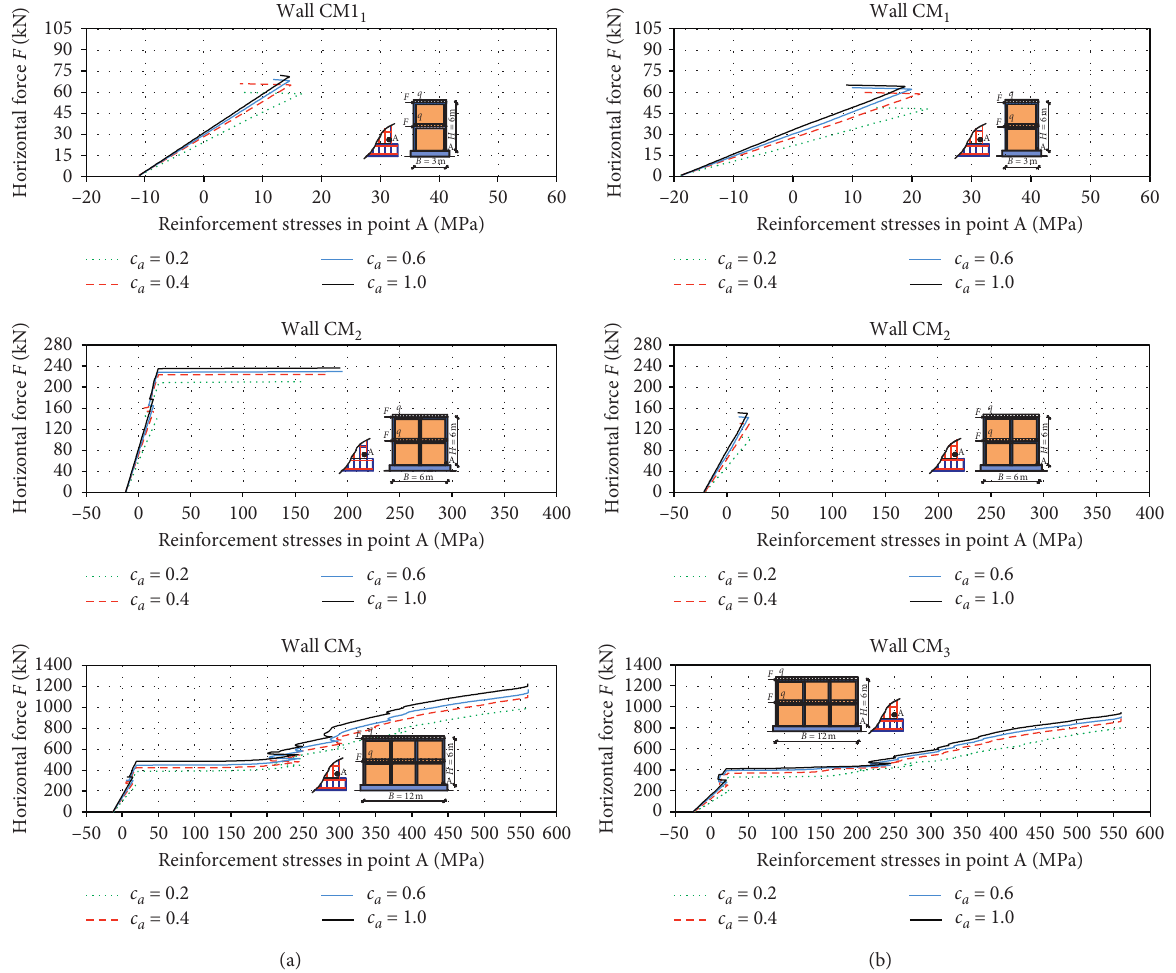
Figure 15: Reinforcement stresses in point A of confined masonry walls: (a) stiff masonry; (b) soft